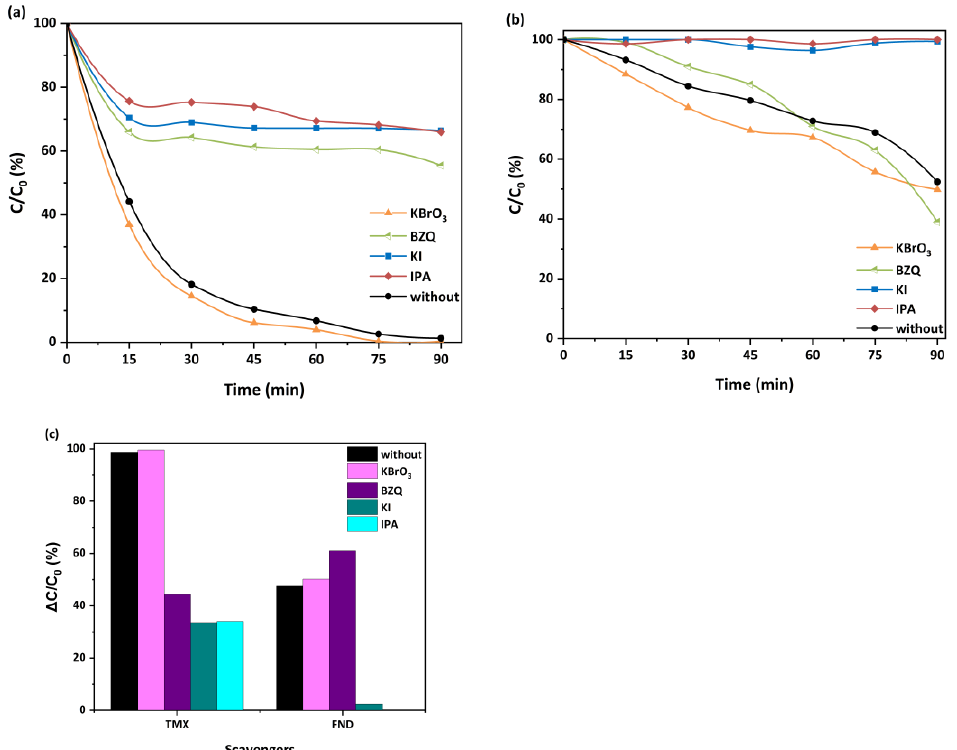
Figure 4. Radical trap experiments of ( a ) thiamethoxam (TMX); and ( b ) flonicamid (FND) in the presence of appropriate scavengers: IPA for • OH quenching, KI for h + , BZQ for O 2 •− and KBrO 3 for e − ; ( c ) Scavengers’ effect on the photocatalytic degradation performance for both pesticides.